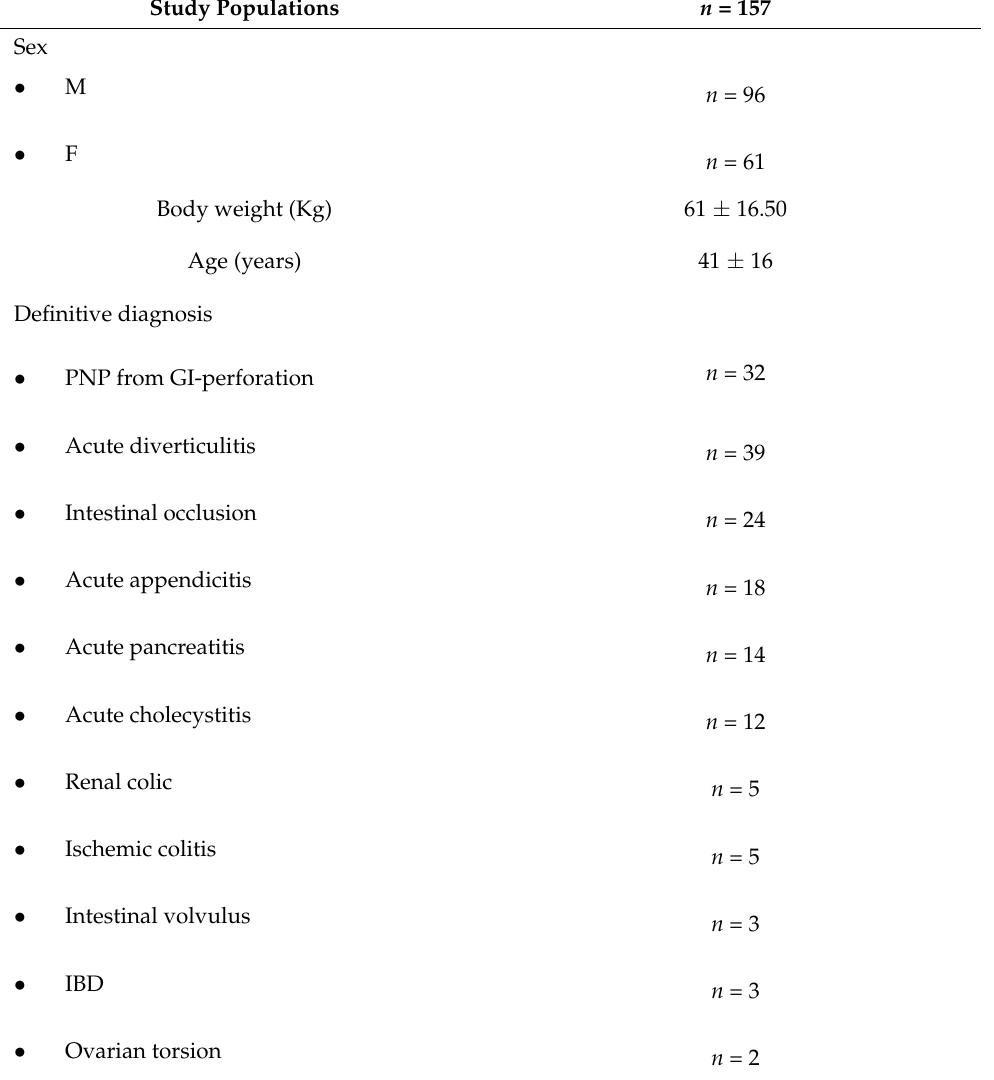
Table 1. Population’s main